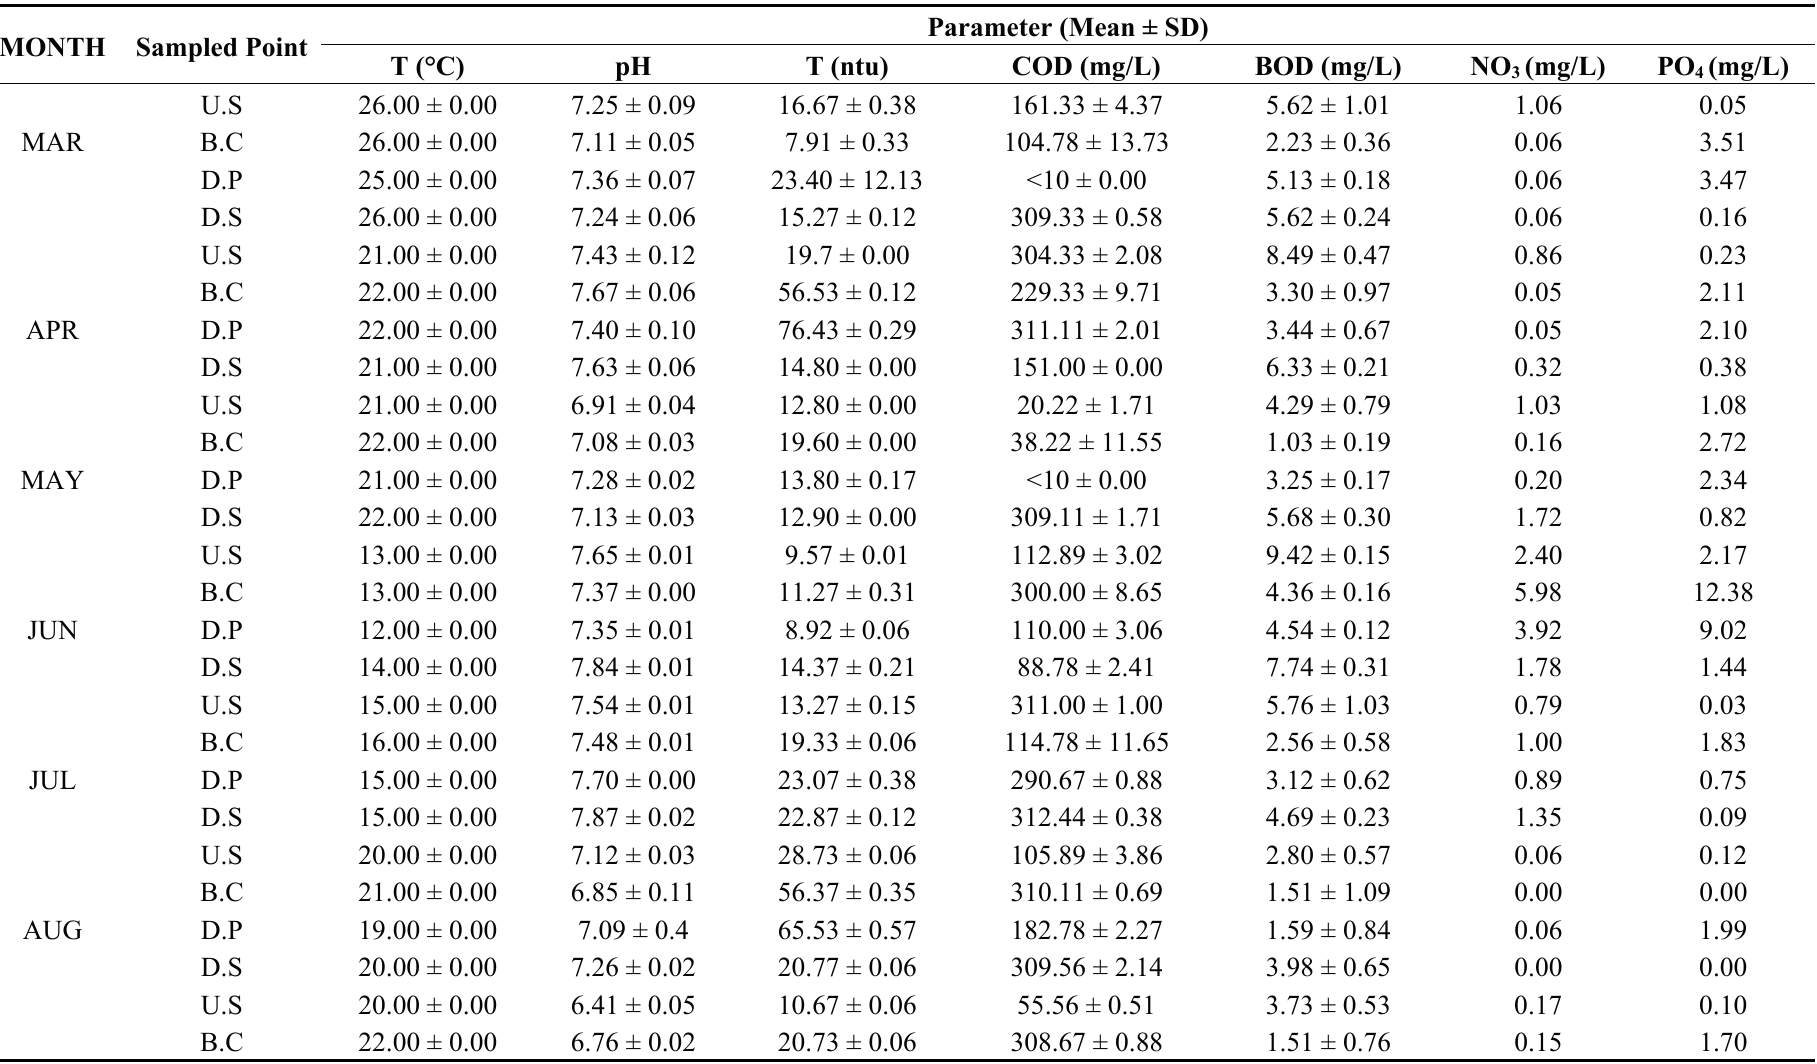
Table 2. Physicochemical parameters of wastewater effluent from Northern wastewater treatment works and the receiving river from March 2012 to February